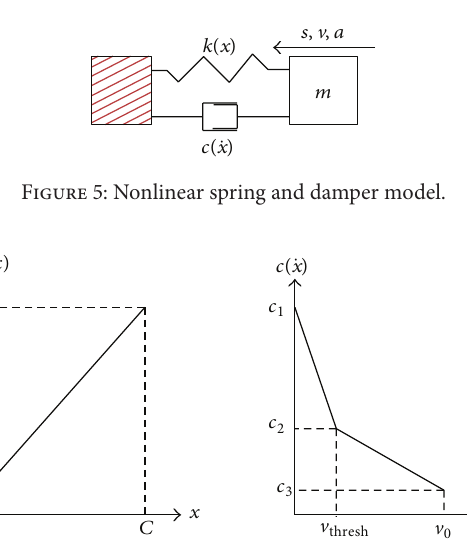
Figure 6: The predefined shape of the nonlinear spring and damper.